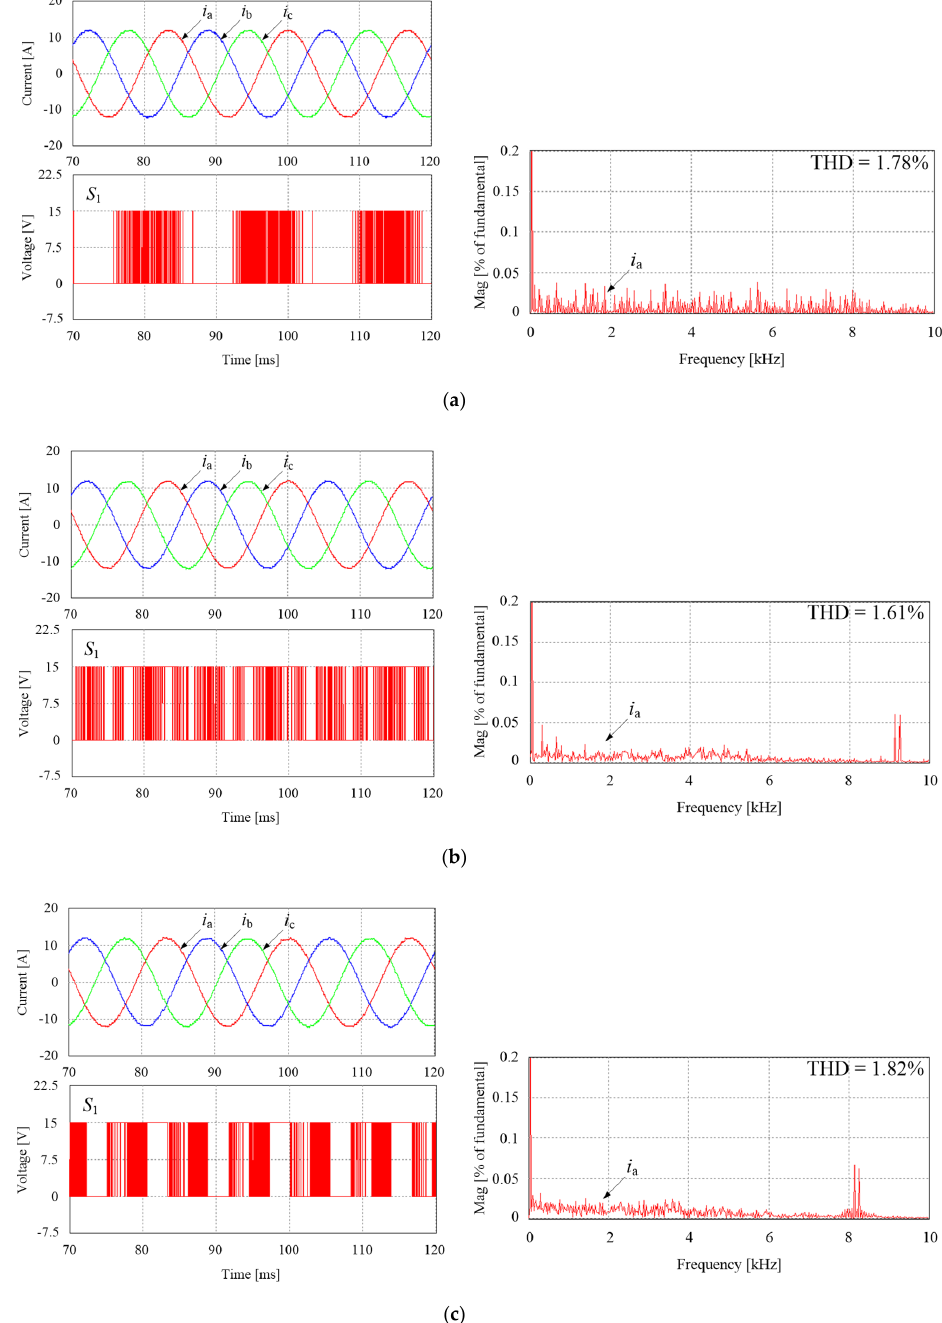
Figure 7. Simulation results of the three-phase output currents ( i a , i b , and i c ), a -leg upper switch S 1 , and the frequency spectrum of the a -phase current ( i a ) with | I * | = 12 A. ( a ) the conventional method using one vector, ( b ) the conventional method using two vectors, and ( c ) the proposed method with switching frequency f switching = 4kHz. THD: total harmonic